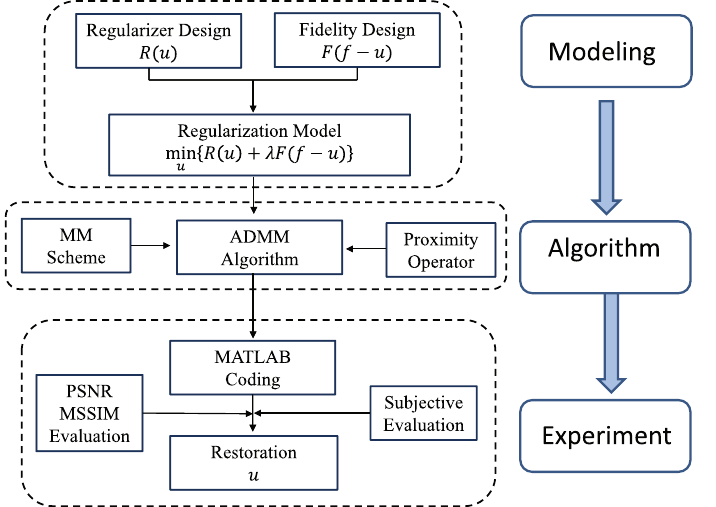
Figure 1. The demonstration of the study design of the present